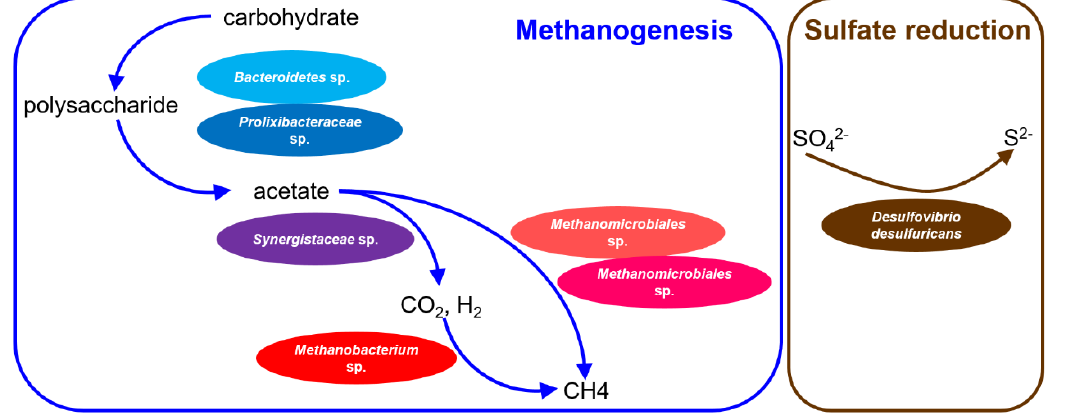
Figure 6. Conceptual graph of the microbial network and dominant metabolic pathways of the microbial communities in the DWTS.